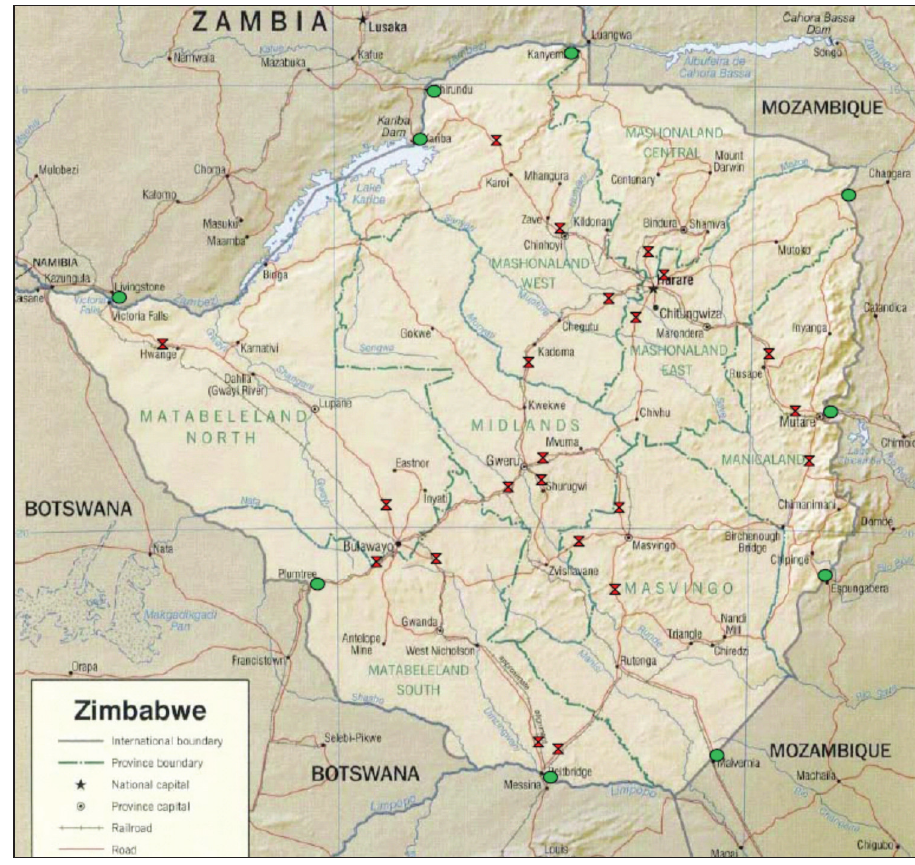
Figure 6: Zimbabwe roads map showing location of toll centres ( ) Traffic volumes and